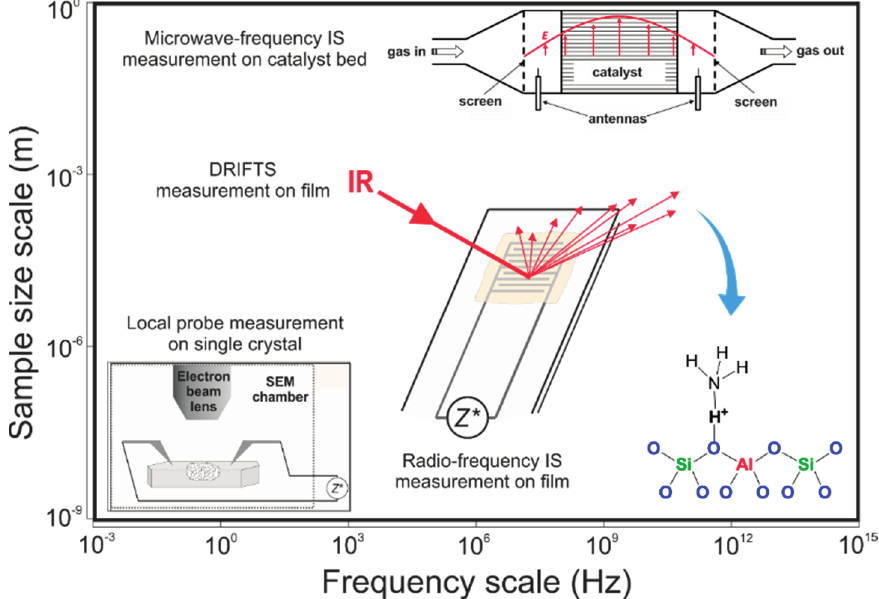
Figure 1. Schematic representation of the spectroscopic techniques at different working frequency ranges and of the probe at different dimensions. It thereby illustrates the different scales of size and frequency, which are assessed by the different experimental techniques described in this